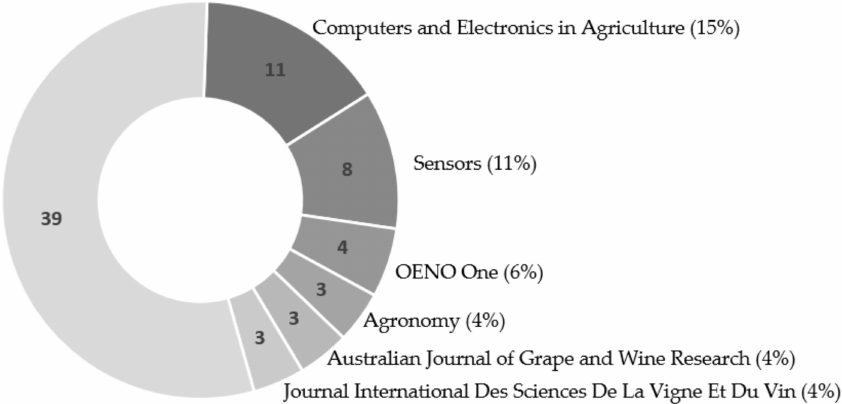
Figure 2. Distribution according to scientific peer-reviewed journals (top 6 highlighted). For an overall perception of the ten different methodological approaches identified for yield estimation, they are represented in Figure 3, created with Circos [31].